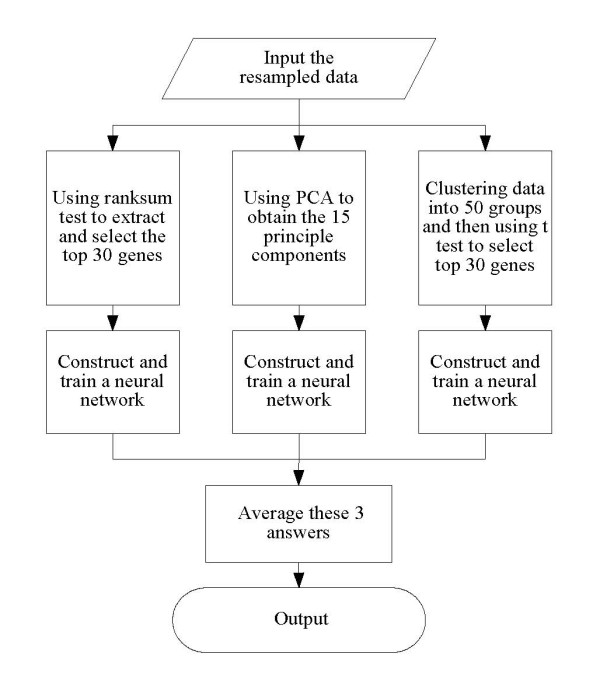
Three cooperative and competitive neural networks